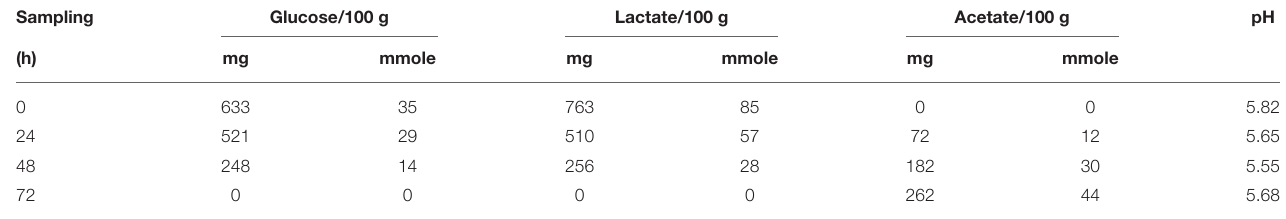
TABLE 2 | Glucose and lactate consumption and acetate production in a meat model over time.